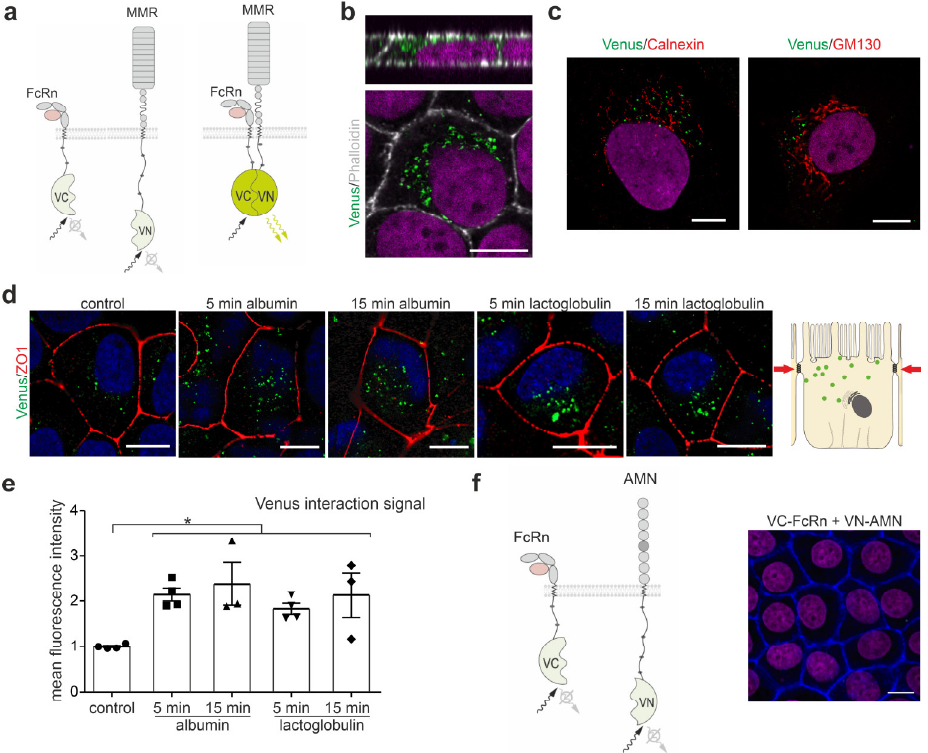
Figure 1. Megalin interacts with FcRn. ( a ) Cartoon of the Venus-based bimolecular fluorescence complementation system used. C-terminal part of the Venus protein is fused to FcRn (VC-FcRn), and the N-terminal part of the Venus protein to the megalin mini receptor MMR4 (VN-MMR4). Fluorescence is generated only when both proteins, FcRn and MMR4, are in close vicinity to each other. ( b ) Labeling of VC-FcRn and VN-MMR4 co-transfected opossum kidney cells (OKC) for 72 h with phalloidin to stain actin fibers, i.e., to visualize the brush border. Nuclei are counterstained with DAPI. Magnification scale bar = 10 µ m. ( c ) Labeling of VC-FcRn and VN-MMR4 co-transfected opossum kidney cells (OKC) for 8 h with calnexin (ER marker) or GM130 (Golgi marker). Magnification scale bar = 10 µ m. ( d ) Venus fluorescence of OKC co-transfected with VC-FcRn and VN-MMR4 for 72 h and endocytosis induction using albumin or lactoglobulin for 5 and 15 min. Cells were stained with anti-ZO-1 to mark tight junctions and DAPI to mark nuclei. Magnification scale bar = 10 µ m. ( e ) Densitometric evaluation of Venus fluorescence intensity per cell area. >150 cells of n = 3–4 independent experiments, Kruskal-Wallis test, * p < 0.05 was considered significant. ( f ) ( left ) Cartoon of the Venus-based bimolecular fluorescence complementation system used. The C-terminal part of the Venus protein is fused to FcRn (VC-FcRn) and N-terminal part of the Venus protein to amnionless (AMN, VN-AMN). ( right ) OKC double transfected with VC-FcRn and VN-AMN. Cells were counterstained with phalloidin to stain actin fibers and DAPI to stain nuclei. No Venus fluorescence was detected. Magnification scale bar = 10 µ